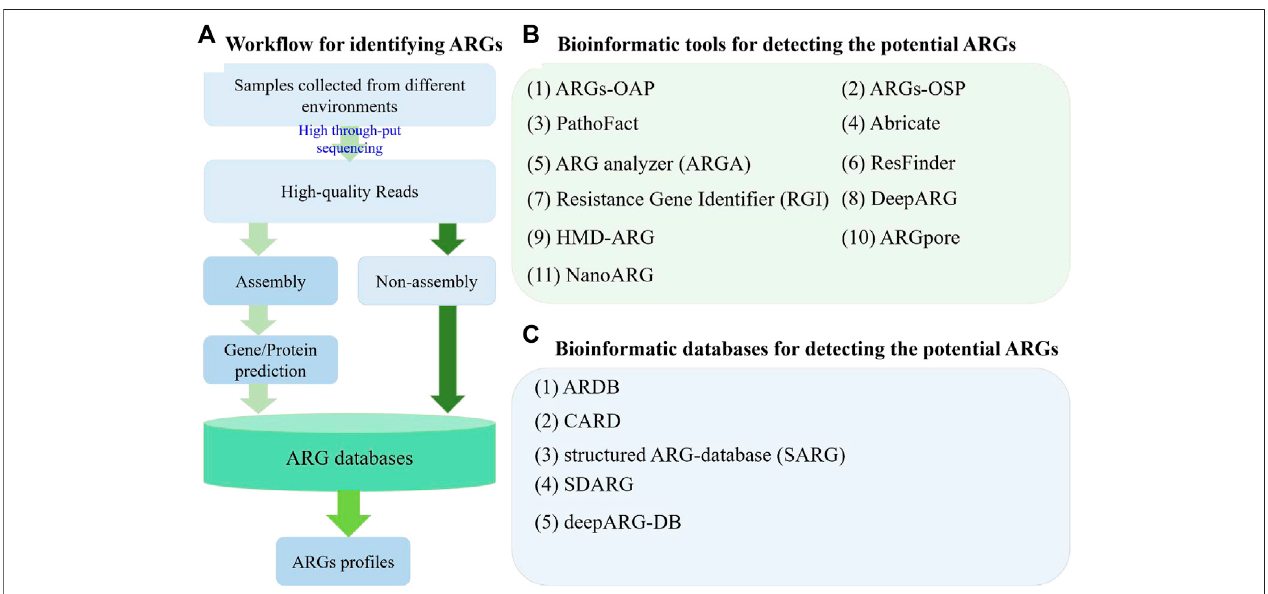
FIGURE 1 | Work fl ow and several bioinformatic tools and databases used in ARG studies for detecting potential ARGs. (A) Two different strategies used in ARG studies for pro fi ling the composition of ARGs based on metagenomic data; (B) Information of several bioinformatic tools used for detecting potential ARGs. (C) Information of several bioinformatic databases used in ARG